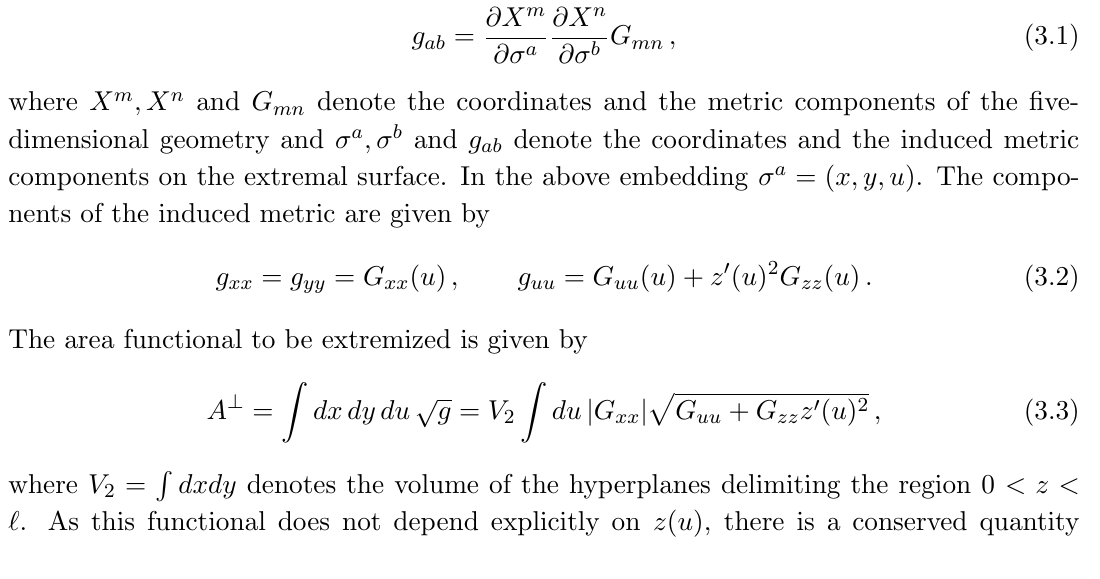
Figure 3 . Butter(cid:13)y velocity as a function of a=T for the MT model. The continuous blue curve represent the result for 3 horizontal line is the isotropic result 3 (cid:12)ve-dimensional Lifshitz-like geometry, 3